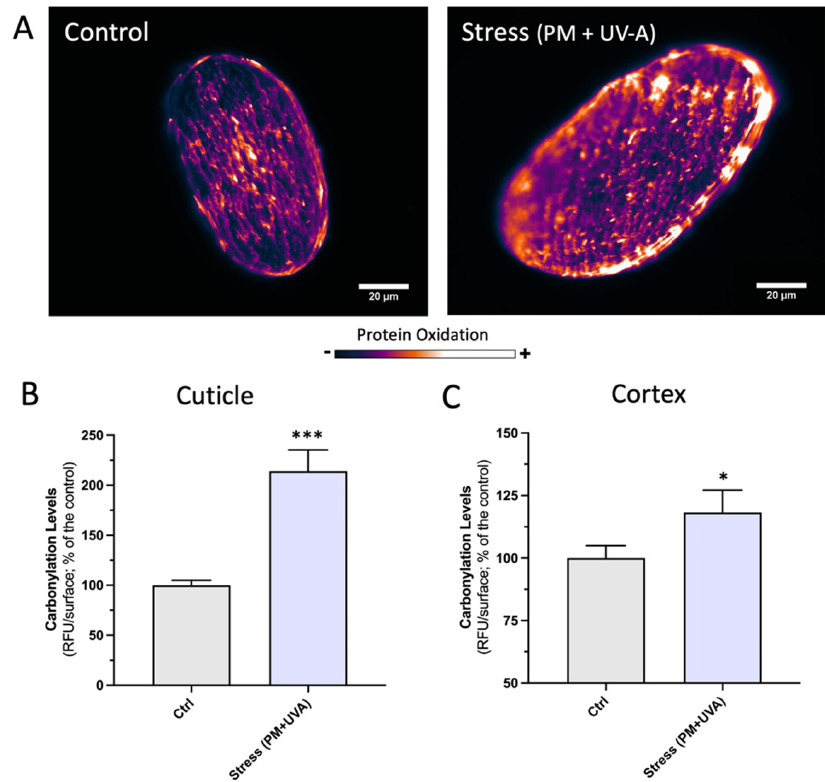
Figure 3. ( A ) The visualization of in situ carbonylation levels on hair cross sections is presented in color range (dark color for low levels and bright colors for high levels of carbonylation. Significant increased levels of carbonylation upon stress (urban pollution) were observed on both cuticle ( B ) and cortex ( C ). Statistics: ANOVA and Dunnett’s post-hoc multi-comparison test versus Control (Ctrl), * p < 0.01 *** p < 0.001.